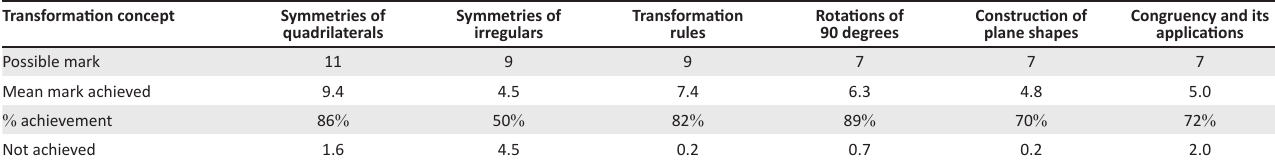
TABLE 3: Distribution of marks per sub-topic. Transformation